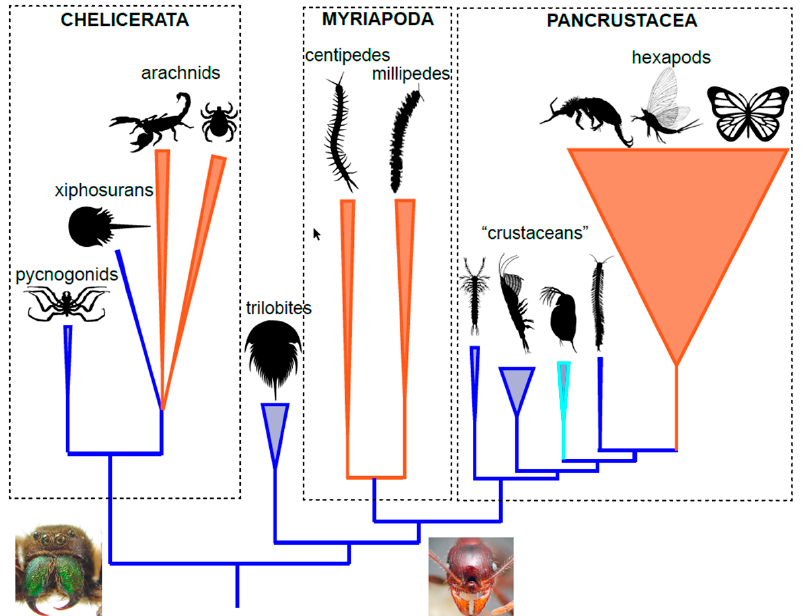
Figure 3. Cladogram with the current consensus on the phylogenetic relationships between the main groups of arthropods. The terrestrial groups are represented in orange colours while the marine clades in blue and turquoise for Branchiopoda (fresh water). The thickness of the terminal branches corresponds to a proportional approximation of the number of described species. At the base of the cladogram, image with detail of chelicerae and mandibles, the defining structures of the two groups. Some of the silhouettes come from Phylopic (phylopic.org/; accessed on 5 November 2022).